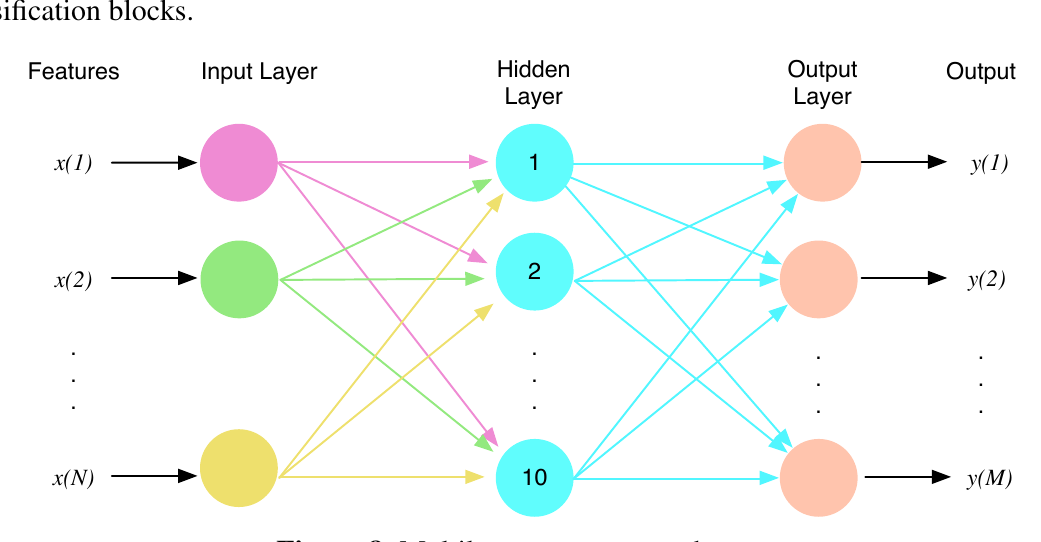
Figure 8. Multilayer perceptron